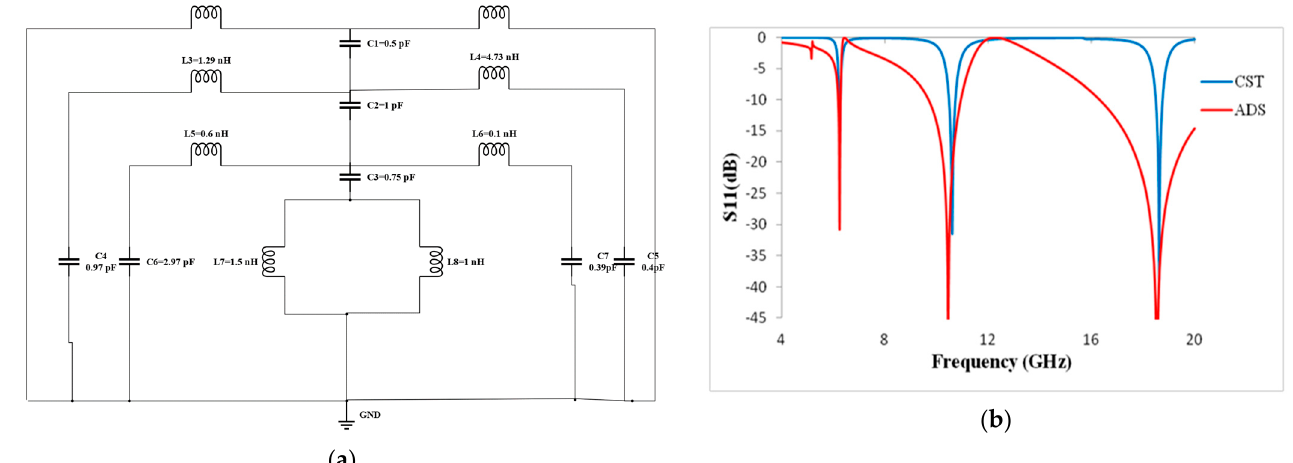
Figure 6. ( a ) Equivalent circuit; ( b ) S